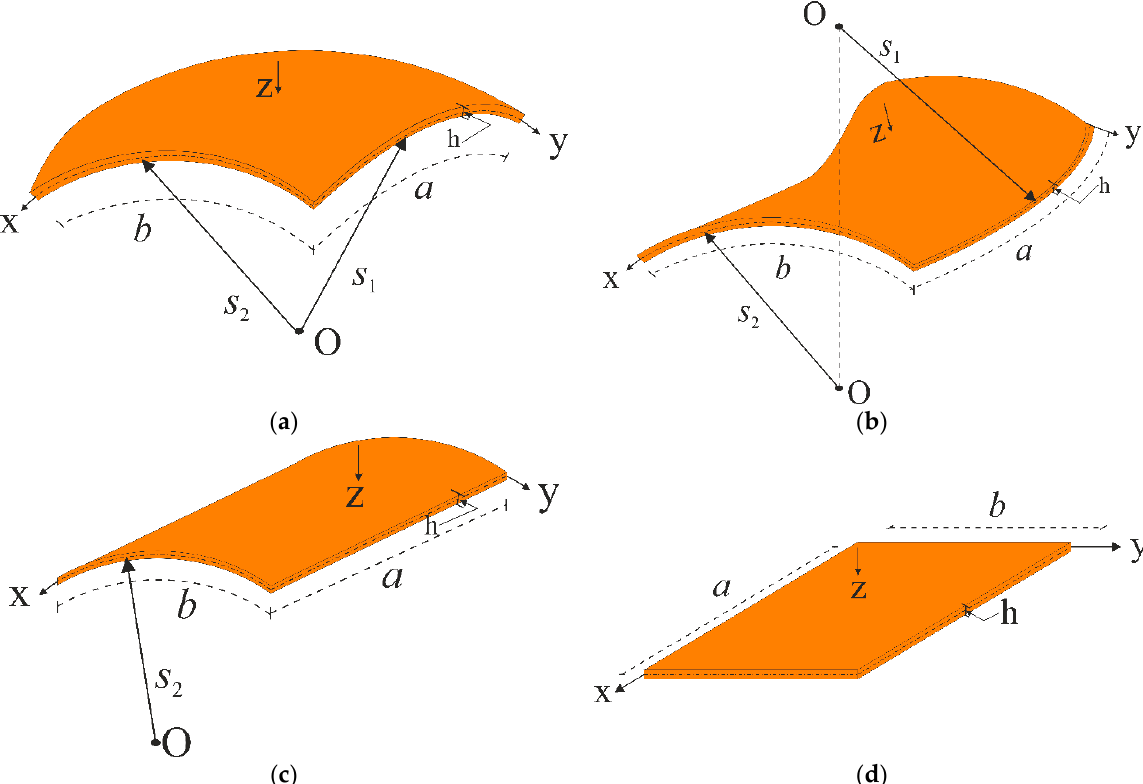
Figure 1. Double-curved shallow shell and coordinate system.